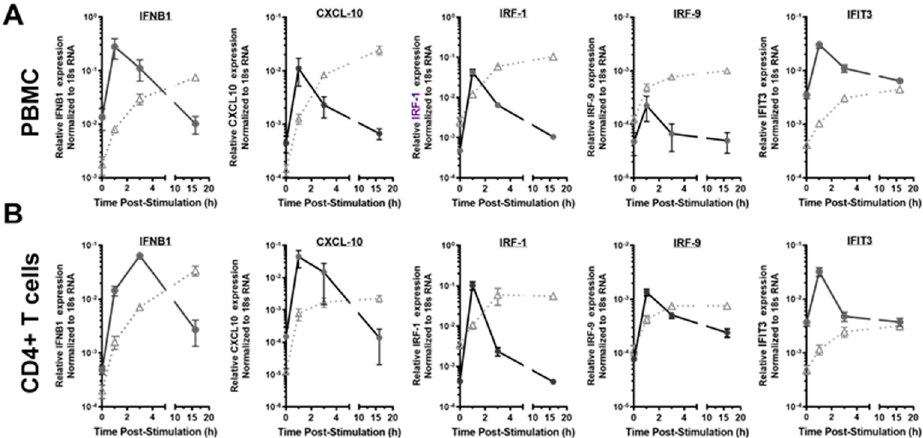
Figure 3. Kinetics of transcriptional response to exogenous IFN- γ stimulation in PBMC and CD4+ T cells. ( A ) PBMC and ( B ) enriched CD4+ T cells from the HESN ( • n = 12) and the non-HESN ( (cid:52) , n = 10) study participants were stimulated with IFN- γ (10 ng/mL) for the indicated time (hour, h). Levels of nascent transcripts of antiviral effector ISGs, including IRF-1, CXCL-10, IFNB1, IRF-9, and IFIT3 were assessed using RT-qPCR and normalized to 18S rRNA levels. We performed t -tests or the transcript levels at each time point between the two study groups.